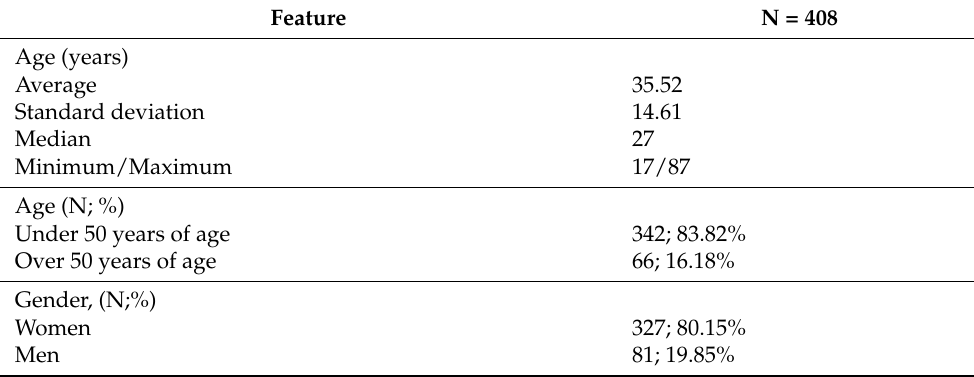
Table 1. Characteristics of the study